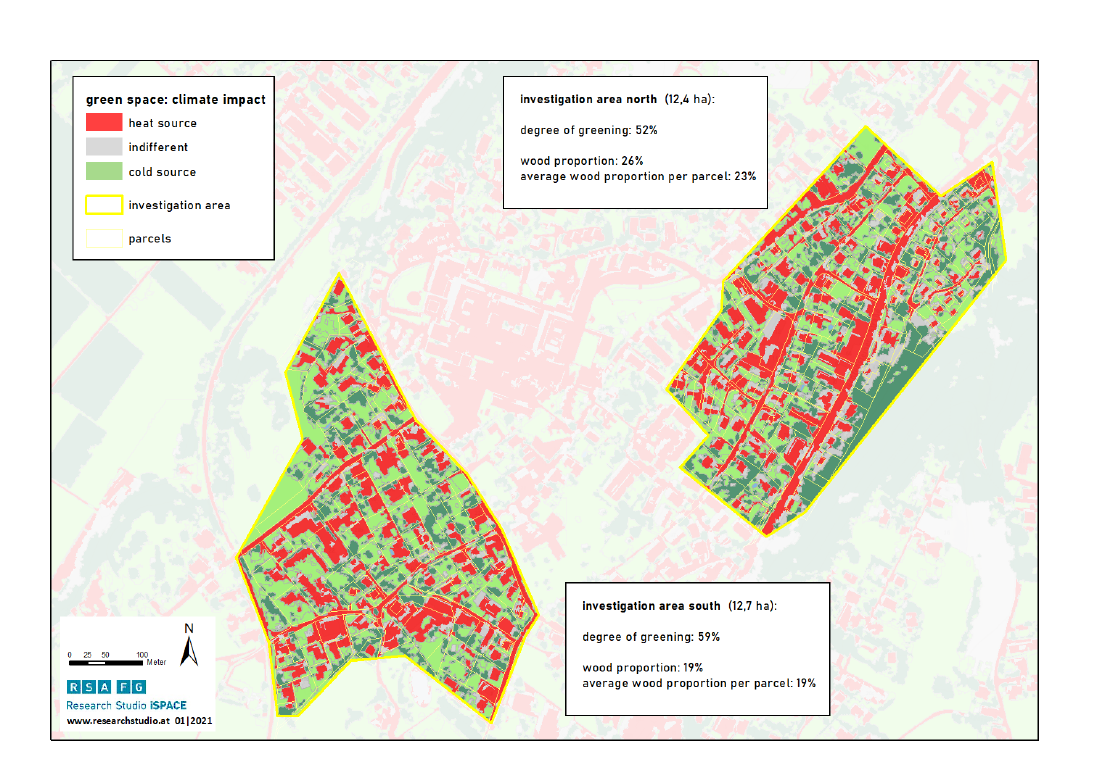
Figure 2. Calculated heated and cooled areas within Tisis, Feldkich (own